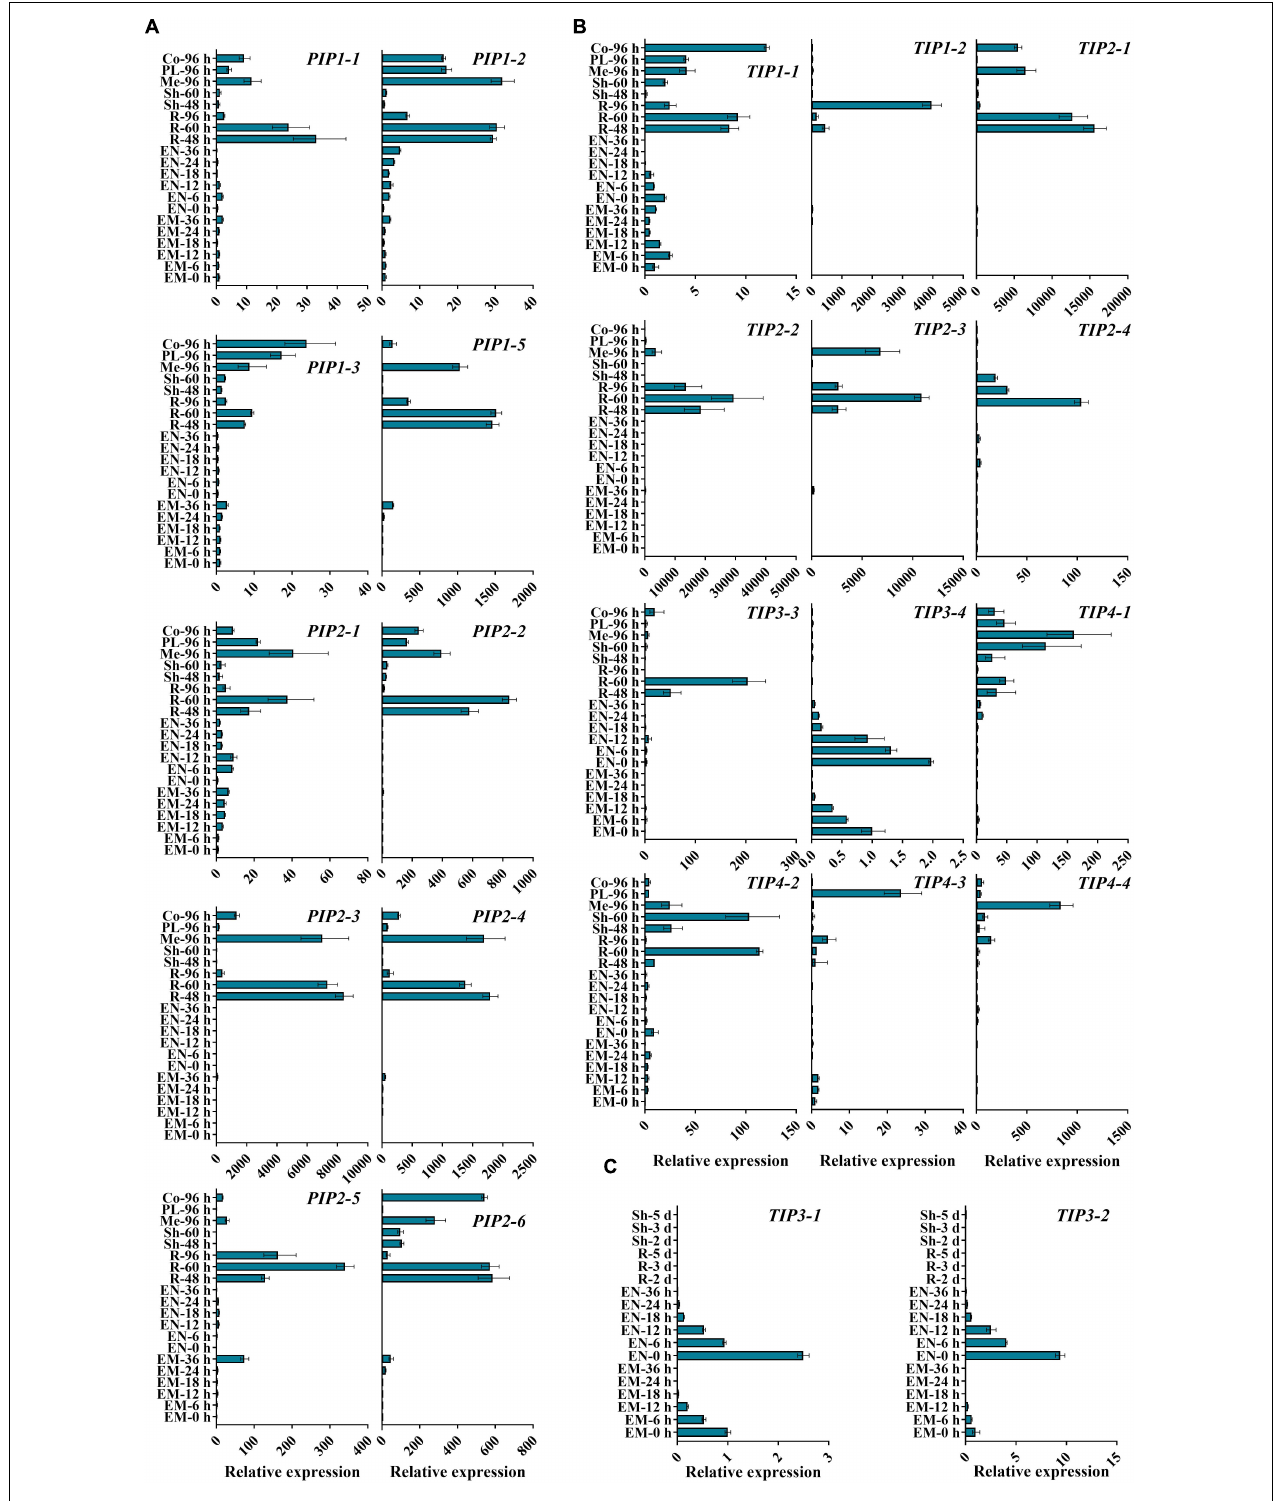
FIGURE 3 | qRT-PCR analysis of the expression levels of ZmAOPs during early seed germination. The relative transcript levels of ZmPIPs (A) and Zm TIPs (B,C) in B73 during the seed germination process. Twenty samples from seeds and seedlings at different times after seed imbibition were used in the assay. ACTIN 1 was used as an internal control. Data are means ± SD ( n = 3). Three independent experiments produced similar results. EM, embryo; EN, endosperm; R, root; Sh, shoot; Me, mesocotyl; PL, plumule; Co, coleoptile.